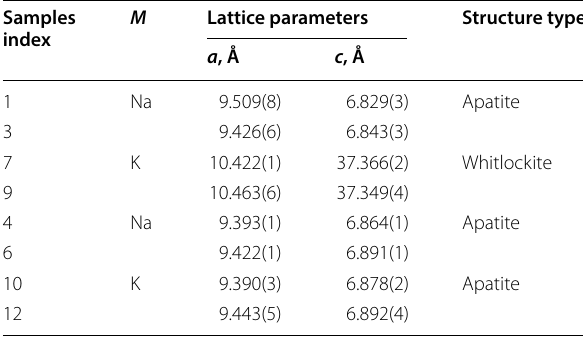
Table 4 The unit cell parameters of obtained complex substituted calcium phosphates after sorption and